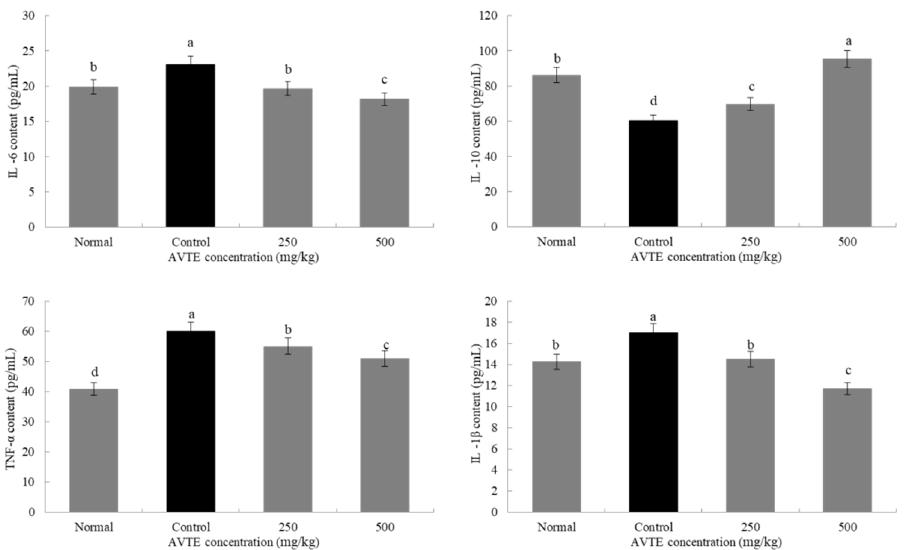
Figure 4. Effects of AVTE on tumor necrosis factor (TNF- α ), interleukin (IL-6, IL-10, and IL-1 β ) in serum of the mice. a–d Mean values with different letters in the same bar graph are significantly different ( p < 0.05) according to Duncan’s multiple range test.